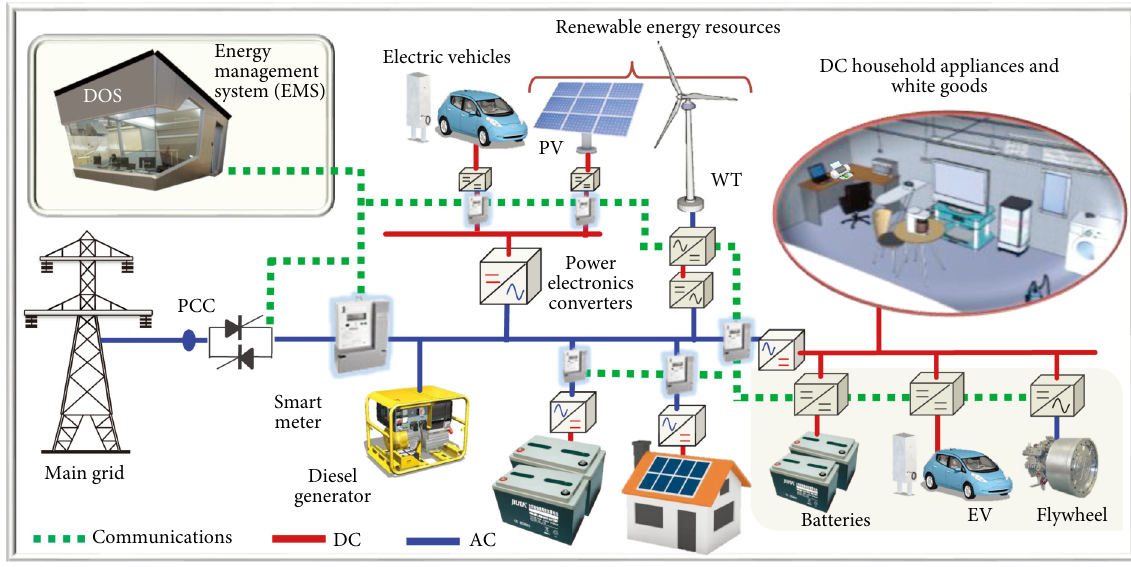
Fig. 6 Demand response in microgrids using smart